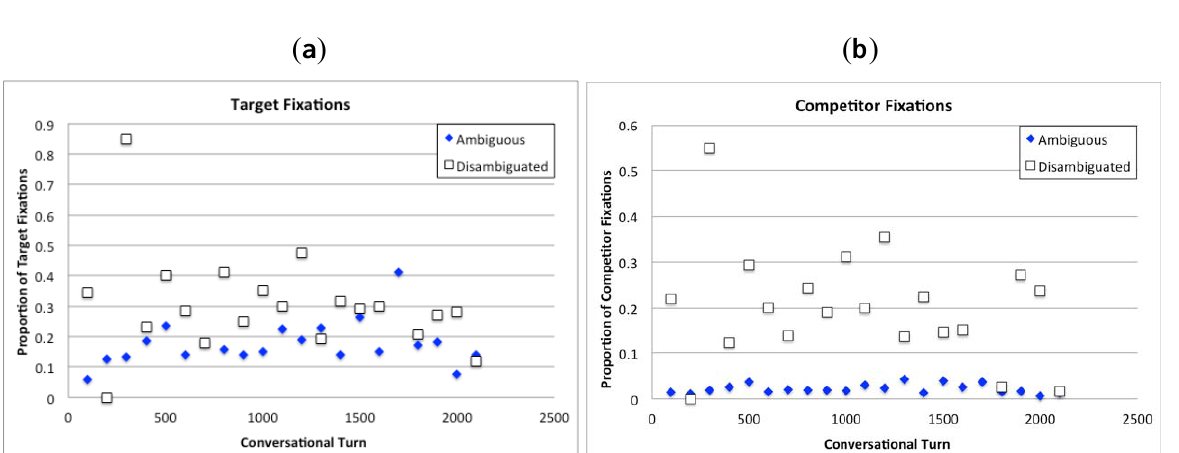
Figure 6. Proportion of fixations to ( a ) target and ( b ) competitor blocks by conversational turn for linguistically ambiguous and disambiguated